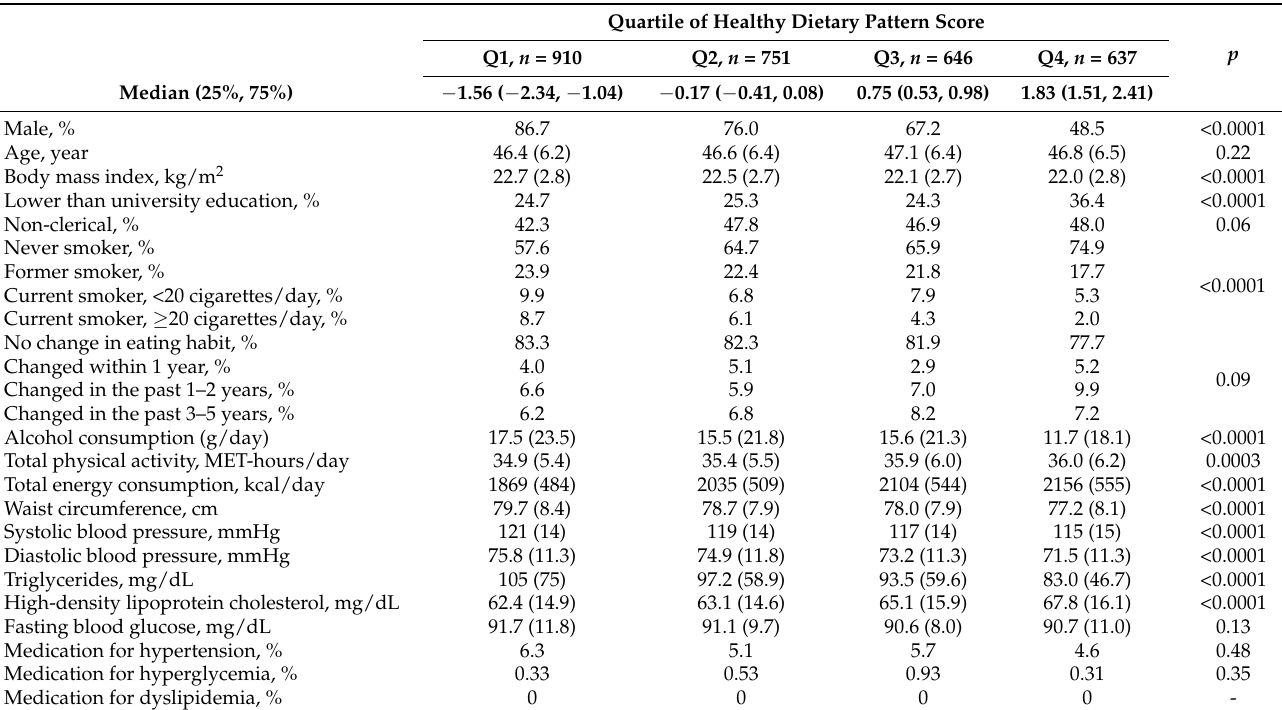
Table 2. Baseline characteristics of the participants according to the quartiles of the Healthy Dietary Pattern for the Aichi Workers’ Cohort, 2013.